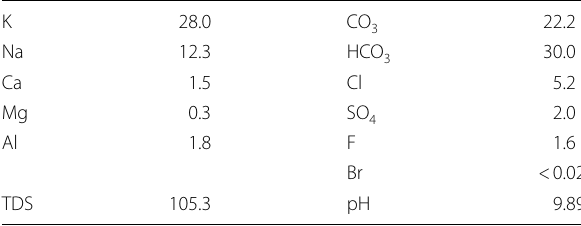
Table 2 Composition of leachate (mg L − 1